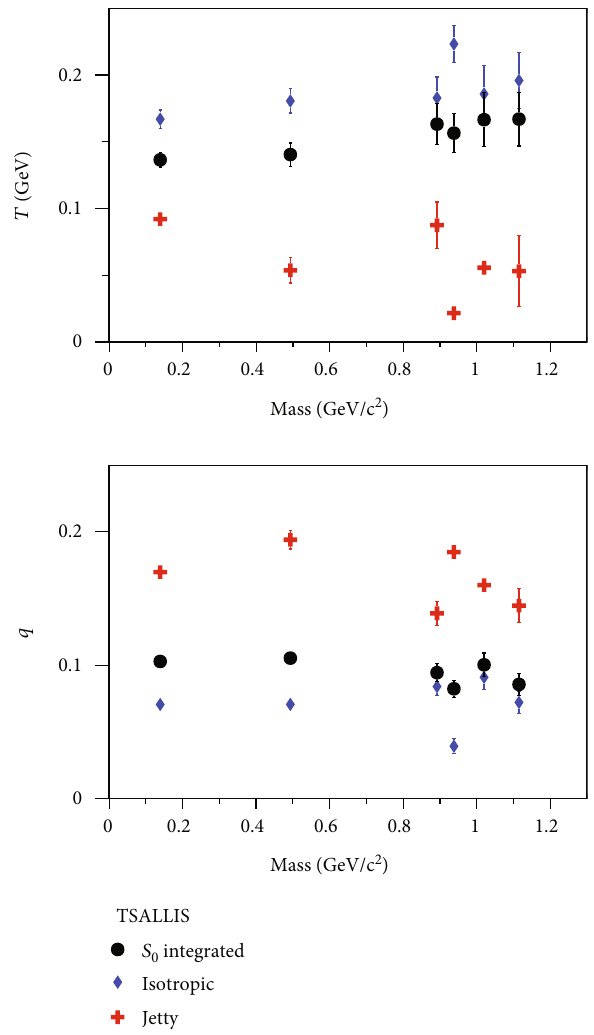
Figure 10: (Color online) Mass dependence of T and q in di ff erent spherocity classes for the highest multiplicity